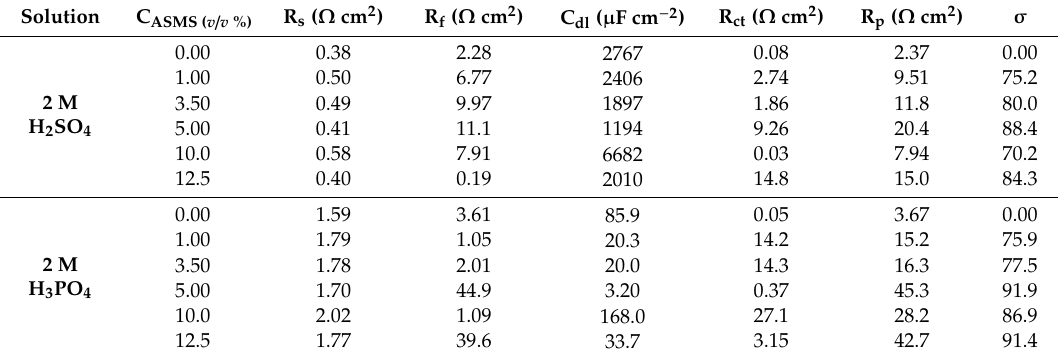
Table 1. Electrochemical impedance parameters in the presence of various concentrations of